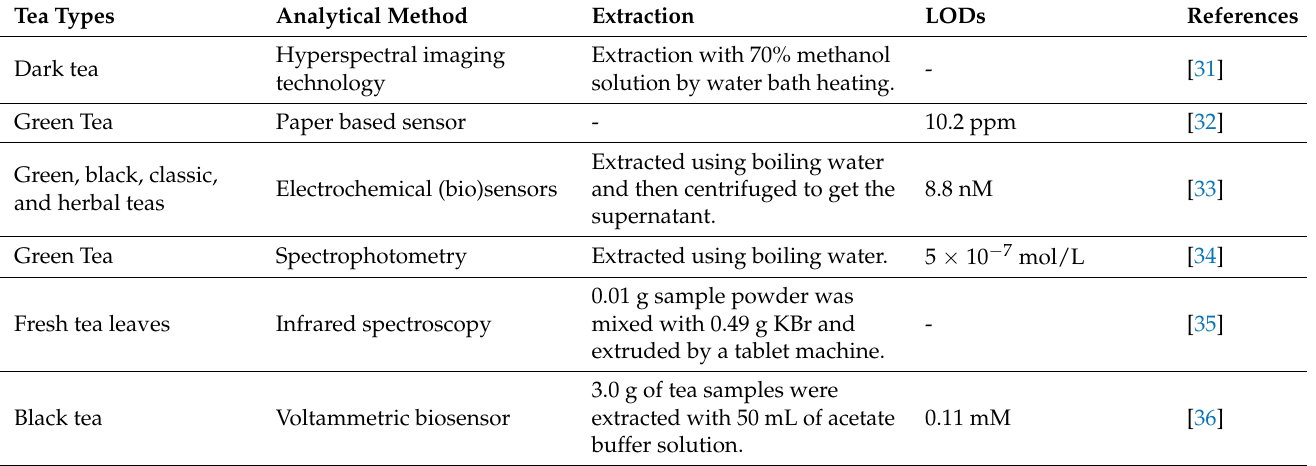
Table 1. Recent applications of determination of total polyphenols in tea.